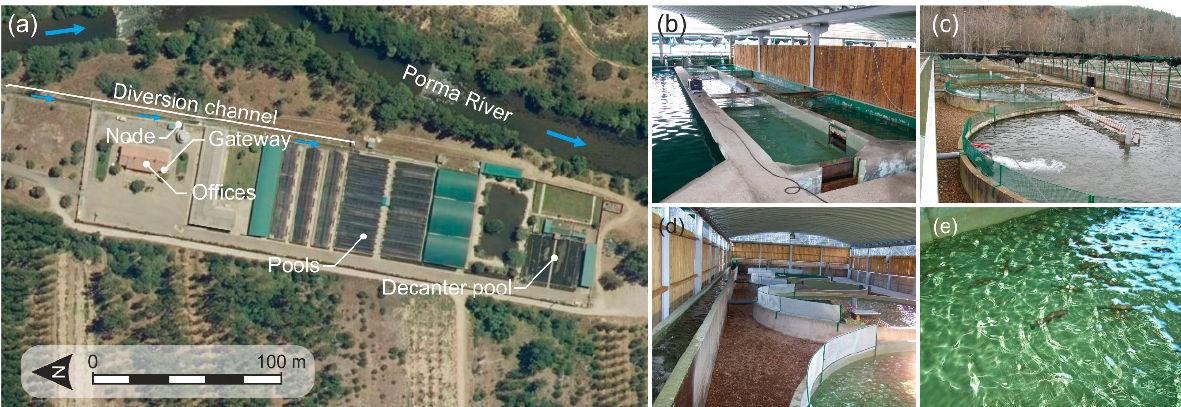
Figure 1. Ichthyogenic Center of Vegas del Condado: ( a ) Plan view of the facility; ( b – e ) Overview of the different pools in the facility.